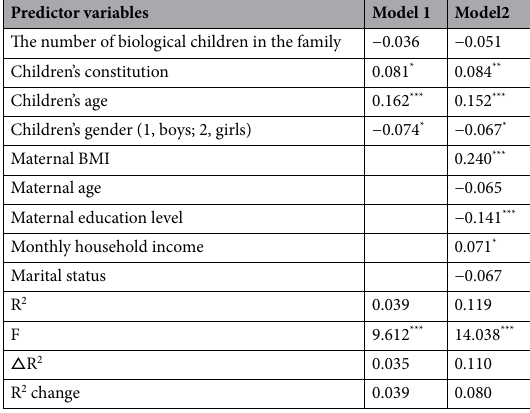
Table 2. Hierarchical Liner Regression of Predictors of children’s BMI. * p < 0.05;** p < 0.01;*** p <